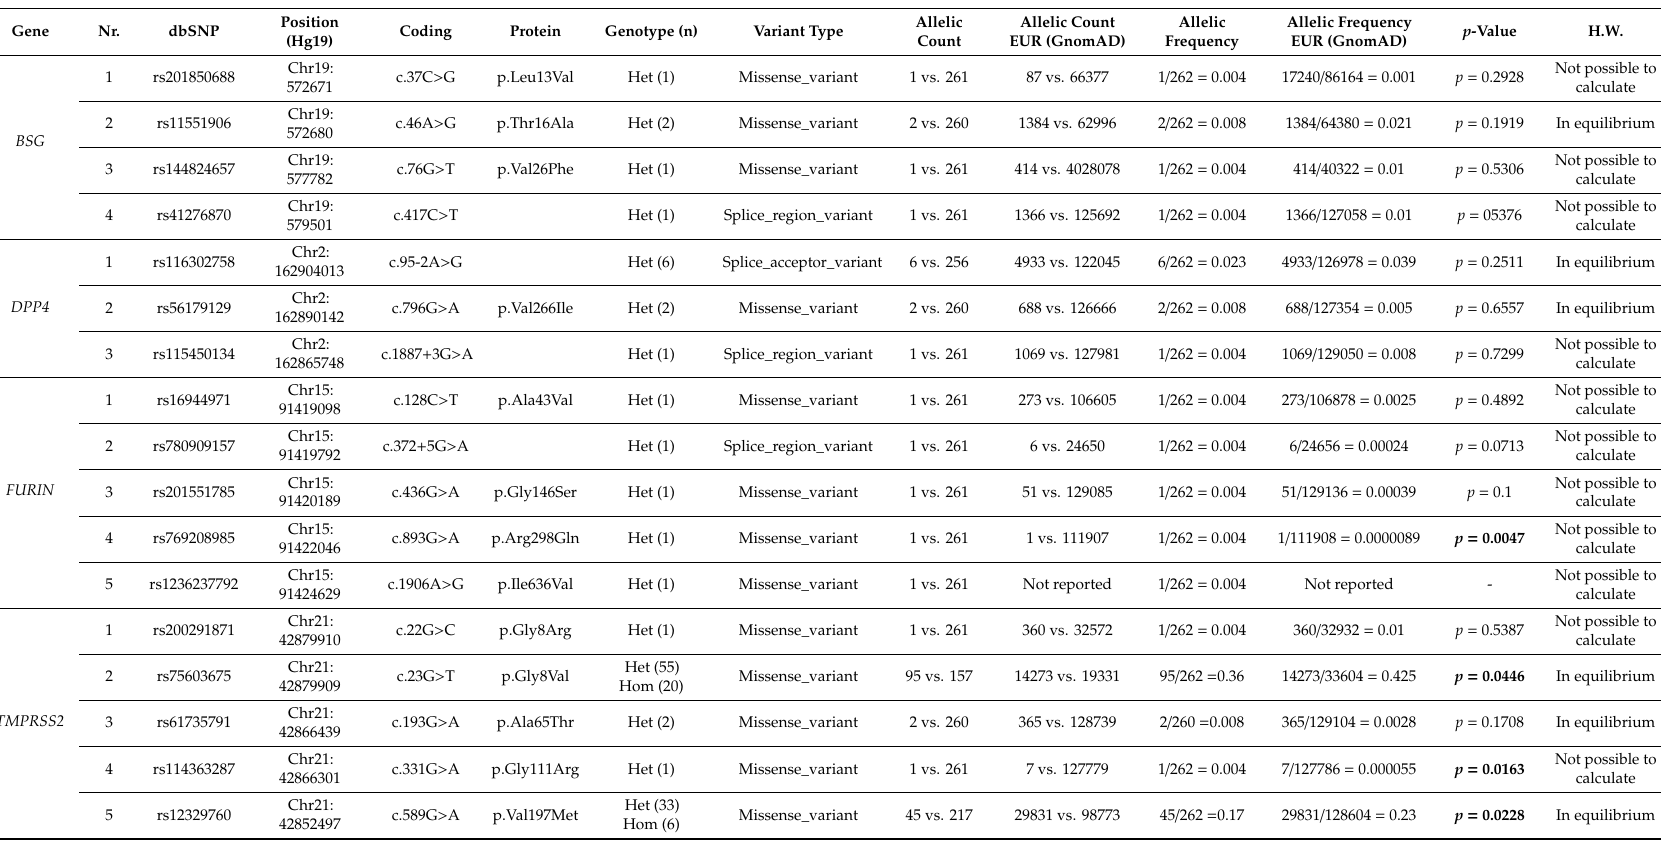
Table 1. Comparison of allelic counts (variant vs. wild type alleles) between our Italian population of SARS-CoV2 Positive Patients and Europeans (GnomAD database).